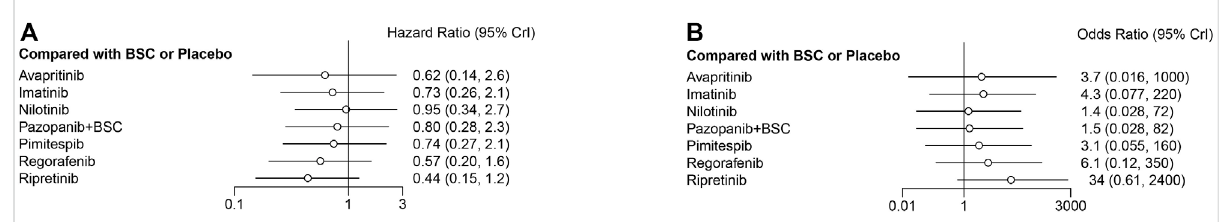
FIGURE 2 Forest plot of the network meta-analysis for PFS and DCR compared with BSC or the placebo. (A) Progression-free survival; (B) disease control